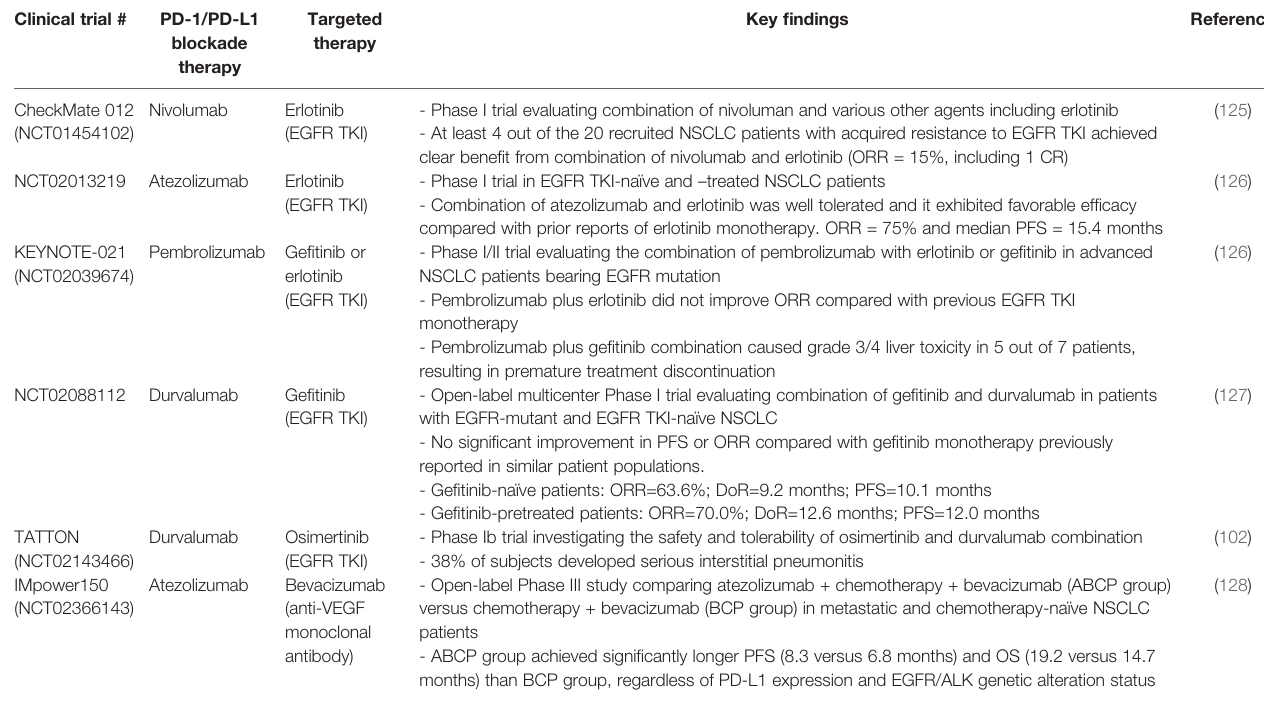
TABLE 3 | Representative clinical trials evaluating the combination of PD-1/PD-L1 blockade immunotherapy and targeted therapy in EGFR-mutant NSCLC patients. Clinical trial